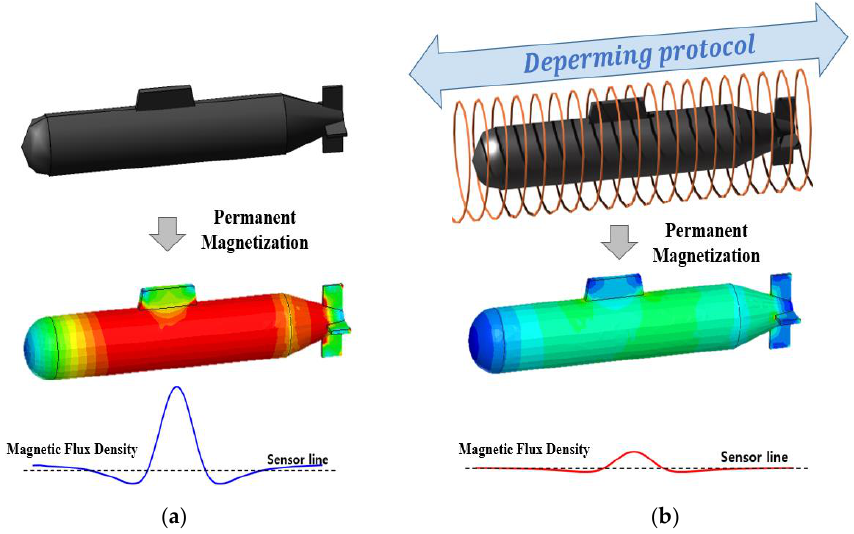
Figure 1. Schematic view of the demagnetization effects: ( a ) effect of the permanent magnetization after manufacturing the warship; ( b ) effect of the demagnetization.